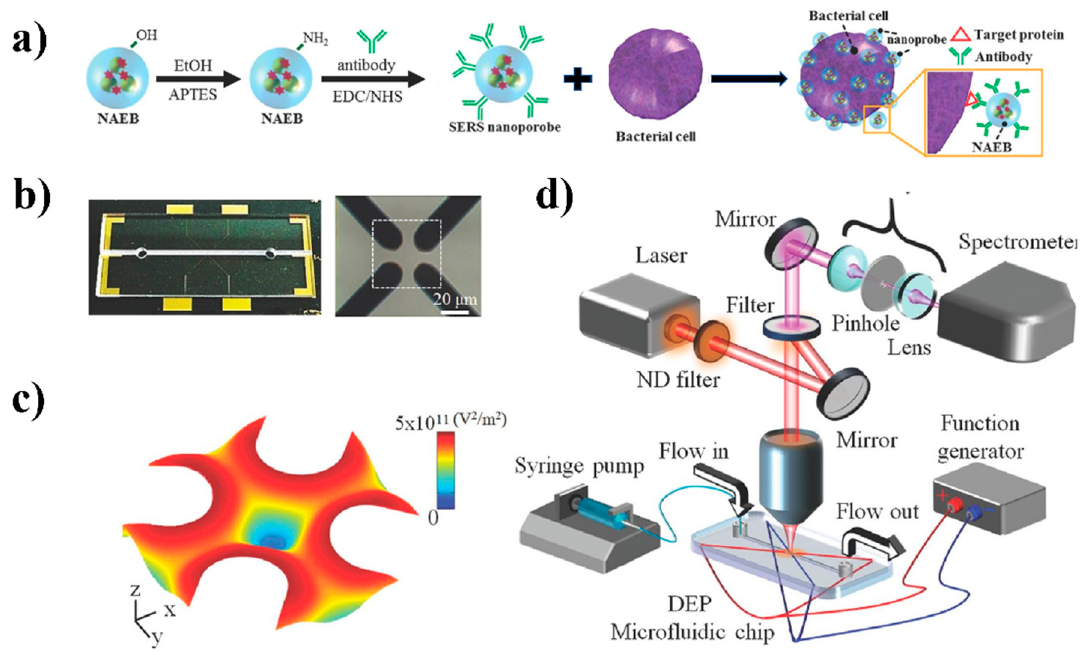
Figure 5. The integration of SERS nanoprobes and a microfluidic dielectrophoresis (DEP) device for rapid detection of single bacterium. ( a ) Schematic presentation of using antibody-conjugated nanoaggregate-embedded beads (NAEBs) as SERS nanoprobes for specific detection of bacteria. ( b ) Photograph of the microfluidic DEP device and close-up view of central capturing area with four the quadrupole electrodes. ( c ) The distribution of electric field of four microelectrodes in the microchannel. ( d ) Schematic illustration of the DEP-SERS configuration. Reproduced with permission [93]. Copyright WILEY-VCH Verlag GmbH & Co. KGaA, Weinheim, 2014.